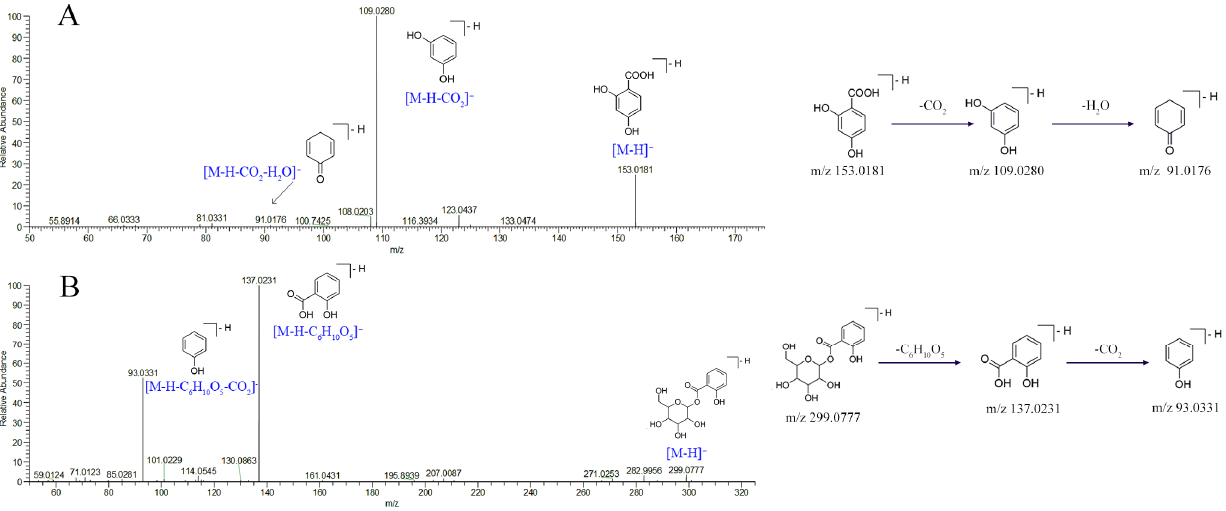
Figure 3. Characteristic of MS/MS spectra and possible fragmentation pathways of protocatechuic acid ( A ) and salicylic acid ‐ O ‐ glucopyranoside ( B